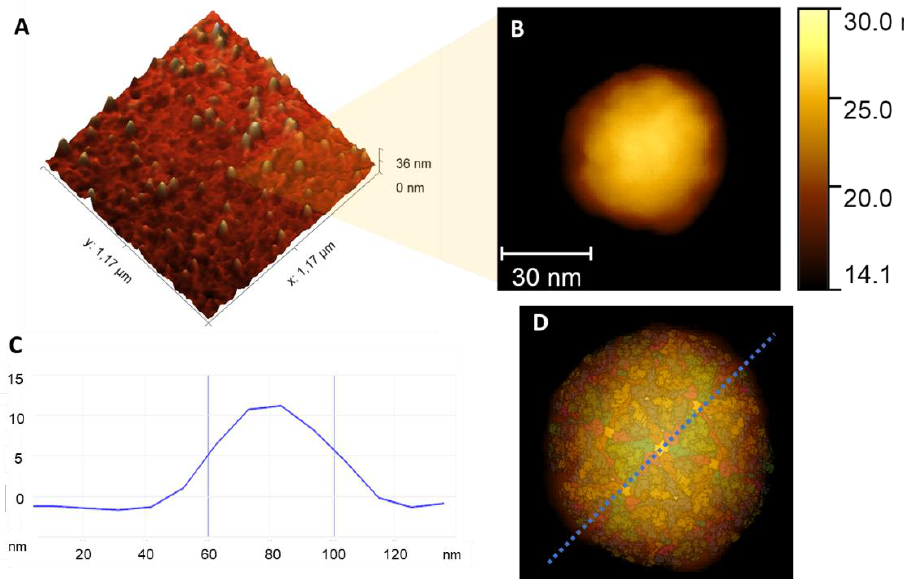
Figure 1. Structure of CHIKV. ( A ) Height image of several viral particles (VPs). The average diameter of the particles is 52.04 nm ± 7.6 nm. ( B ) Height image of an individual CHIKV viral particle. ( C ) Cross-section of a single VP, corresponding to the dotted line in ( D ). ( D ) Correlation between Chikungunya virus modeling [25] and AFM height image.